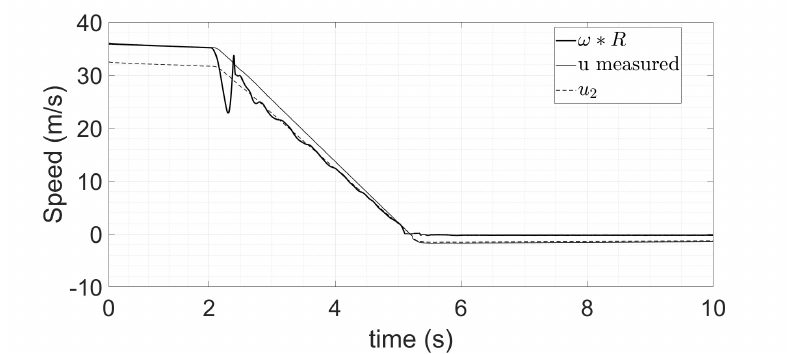
Figure 6. Wheel Speed control threshold